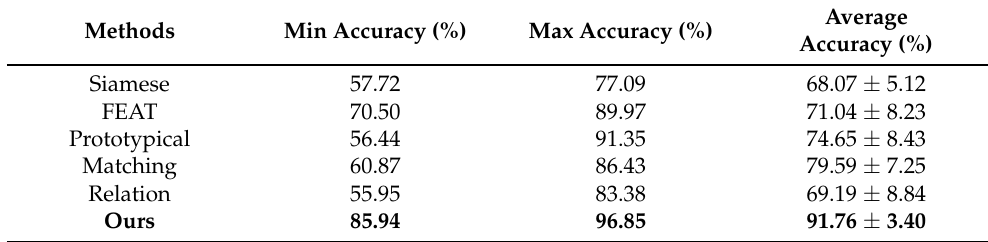
Table 6. “4-way 1-shot” recognition performance of different methods on the MSTAR dataset.